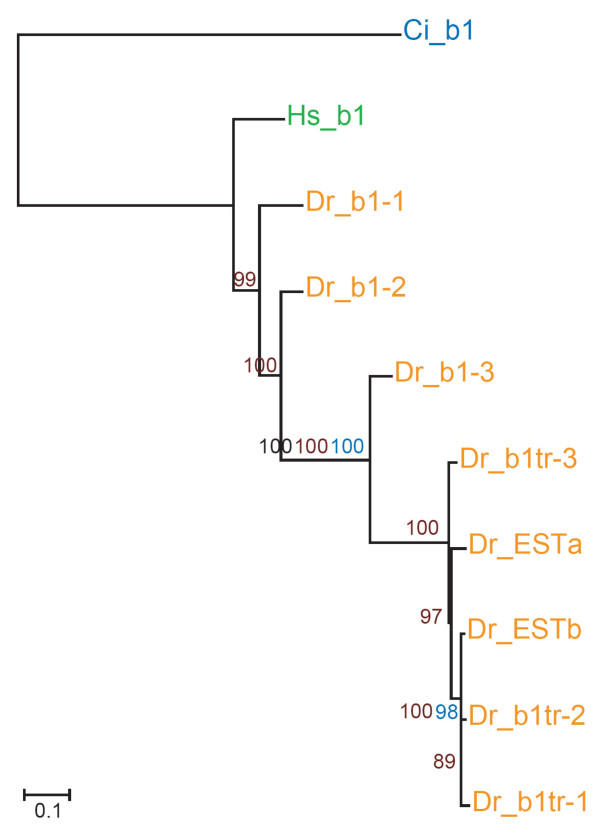
Phylogenetic relationship of zebrafish (Dr) β1 integrin chains with representative deuterostome orthologs. Maximum Likelihood tree is shown with supporting Neighbor Joining bootstrap replicates (black), Maximum Parsimony bootstrap replicates (blue) and Bayesian clade credibility values (brown). Horizontal scale is amino acid replacements per site. Ciona intestinalis β1 (Ci_b1) was used to root the tree; homo sapiens β1 (Hs_b1) is shown as an example of tetrapod sequence.